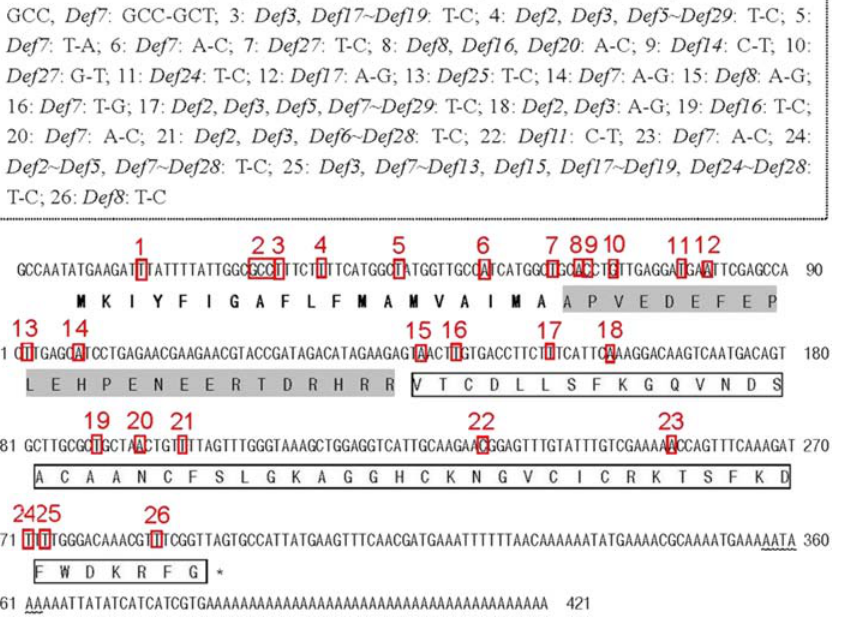
Figure 2. Nucleotide sequence and predicted amino acid sequence of Defensin1 (GenBank Accession EU727268). The putative signal peptide is bolded, the proregion of the peptide is shadowed, and the mature peptide is indicated by an open box. The translational signal (TAG) is indicated by the star symbol. Restriction and poly (A) adenylation signals (AATAAA) are indicated by a wavy line. The variant loci are boxed and numbered in red. The nucleotide substitution sites in the precursor sequences between Defensin1 and other Defensin genes are boxed with a dotted line. ‘‘ Defensin1 , Defensin 29 ’’ is abbreviated to ‘‘ Def1 , Def29 ’’.